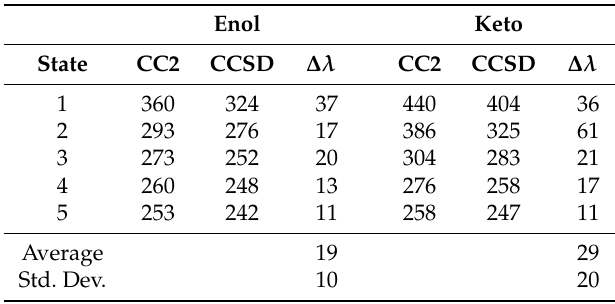
Table 6. Wavelengths of excitation of the first five excited states (in nm) and error ( ∆ λ ) and the average error and standard deviations (Std. Dev.) with respect to CCSD for the isolated forms of PYV3 [PYV3]. All calculations employ the RI approximation and the def2-TZVPD basis